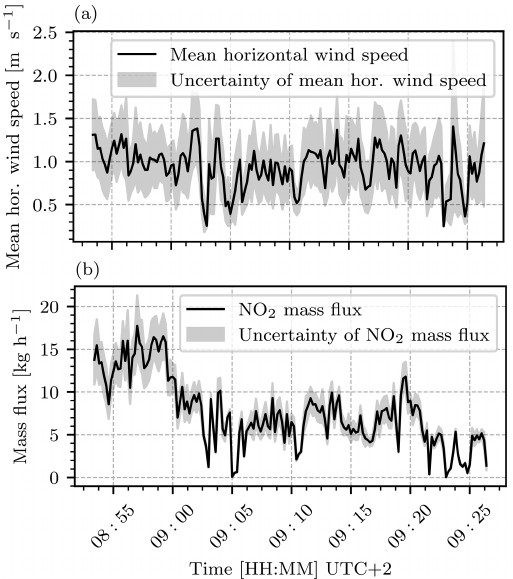
Figure 18. Evaluation of average horizontal wind speeds and NO 2 mass fluxes based on the camera images recorded on 26 April 2021 between 08:55 and 09:25UTC+2. (a) The mean horizontal wind speed, as obtained from the Farnebäck algorithm for consecutive image pairs. (b) The resulting mean NO 2 mass fluxes calculated according to Eq.